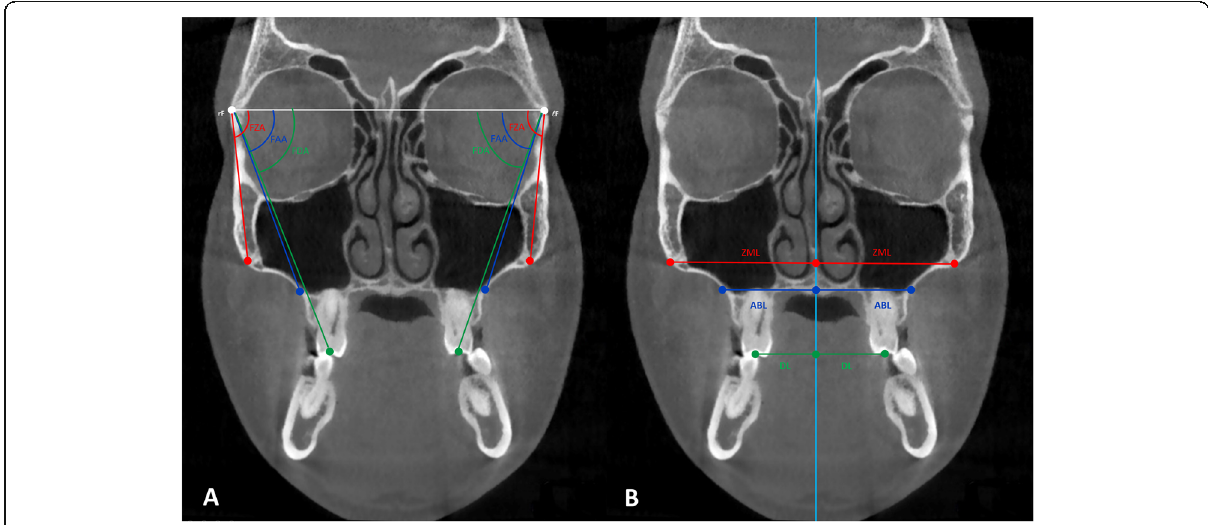
Fig. 7 Measurement systems in the coronal zygomatic section. a Angular measurement system: frontozygomatic angle (FZA), frontoalveolar angle (FAA), and frontodental angle (FDA); rF, right fulcrum; lF, left fulcrum. b Linear measurement system: zygomaticomaxillary line (ZML), alveolar bone line (ABL), and dental line (DL). Light blue line represents the maxillary sagittal